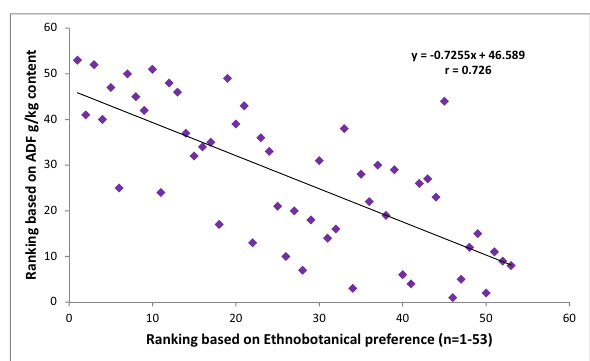
y = -0.7255x + 46.589 r = 0.726